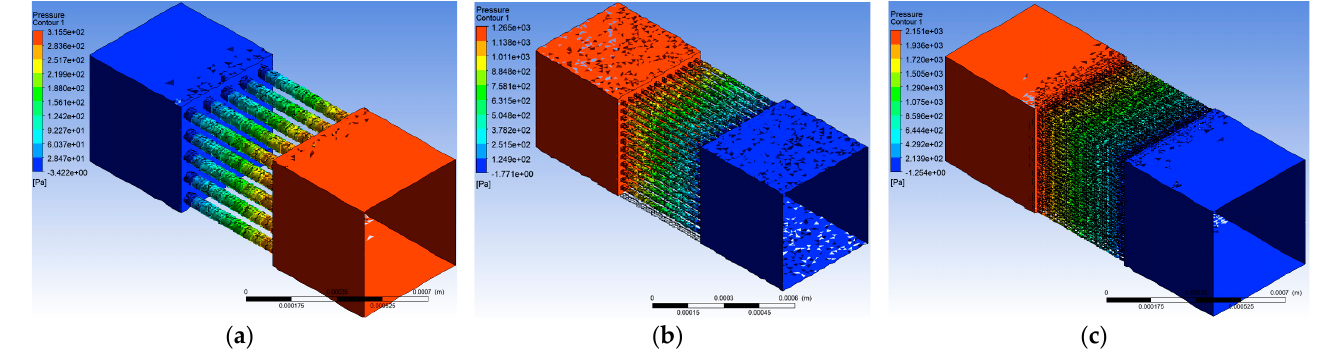
Figure 5. Surface contours of pressure variation in middle detalization model of ( a ) case I—50 µm, ( b ) case II—20 µm and ( c ) case III case—10 µm of porous mycelium media. The model extracted the distribution of air flow trajectories and, being important for entire structure of the porous object, which characterizes the mycelial filler (Figure 6).